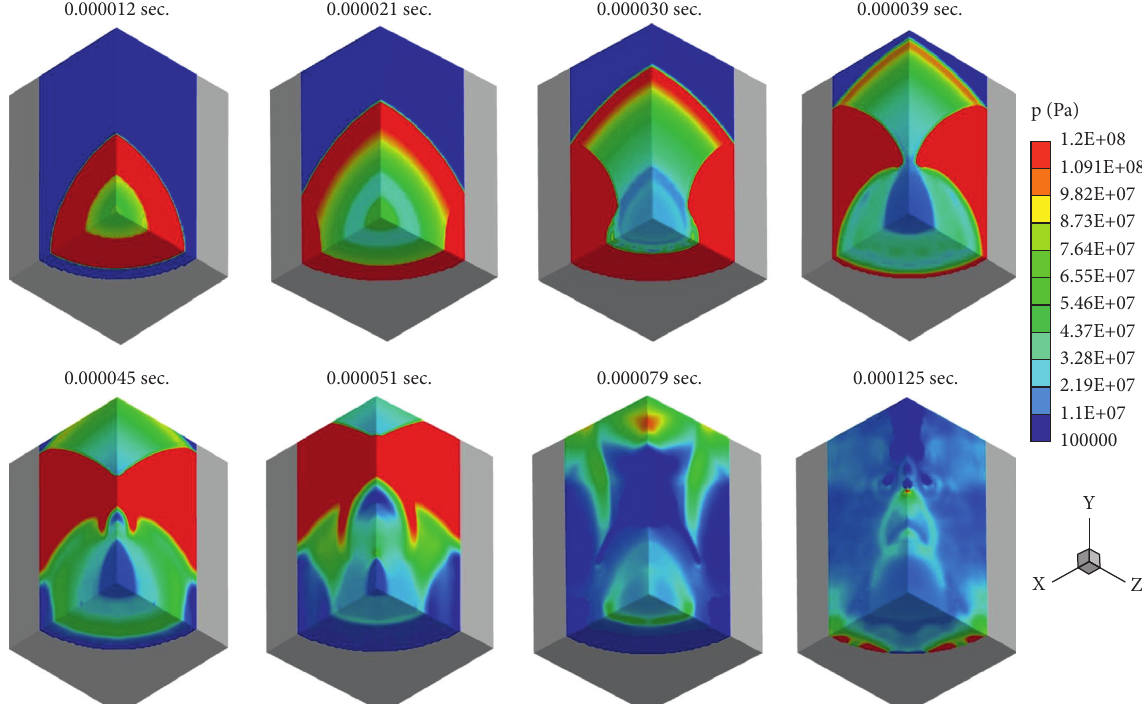
Figure 26: Pressure contours inside the rigid wall tube (3D simulation).